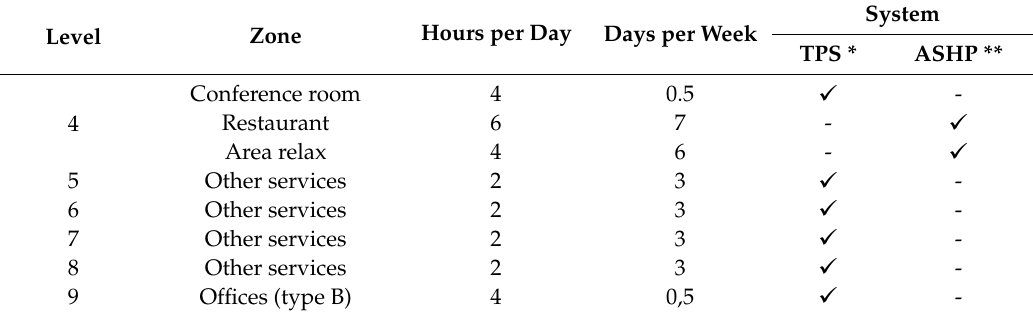
Table 1. UEFA Euro 2016 new arenas’ configuration [47].